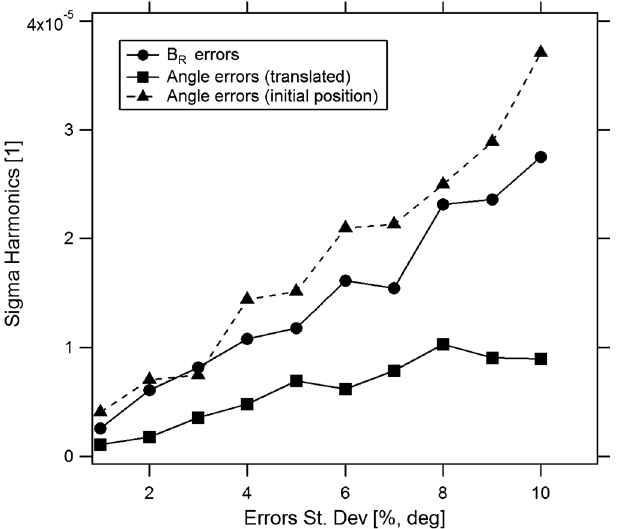
FIG. 8. Simulations of magnet sensitivity to mechanical errors.